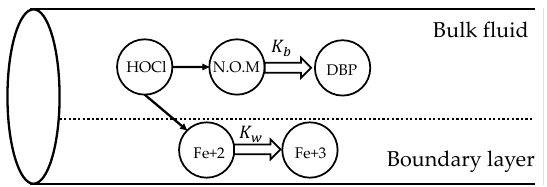
Figure 2. Reaction zones within a